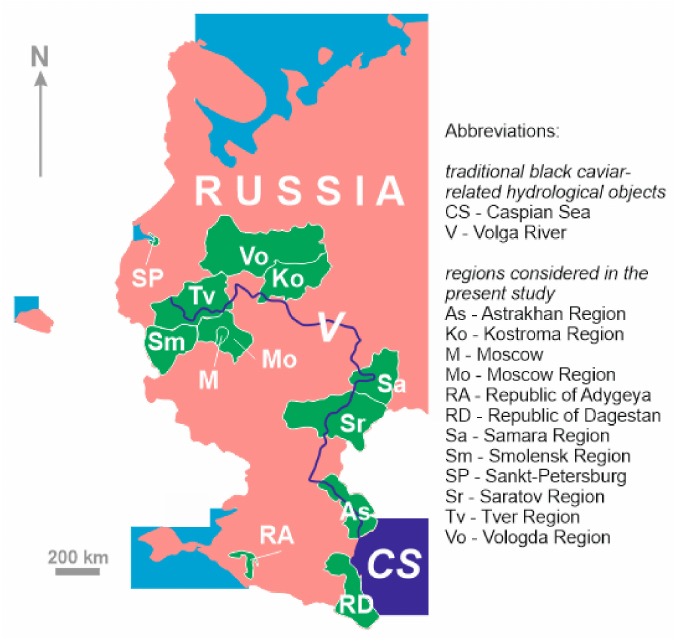
Figure 1. The geographical affinities of the Russian black caviar considered in the present